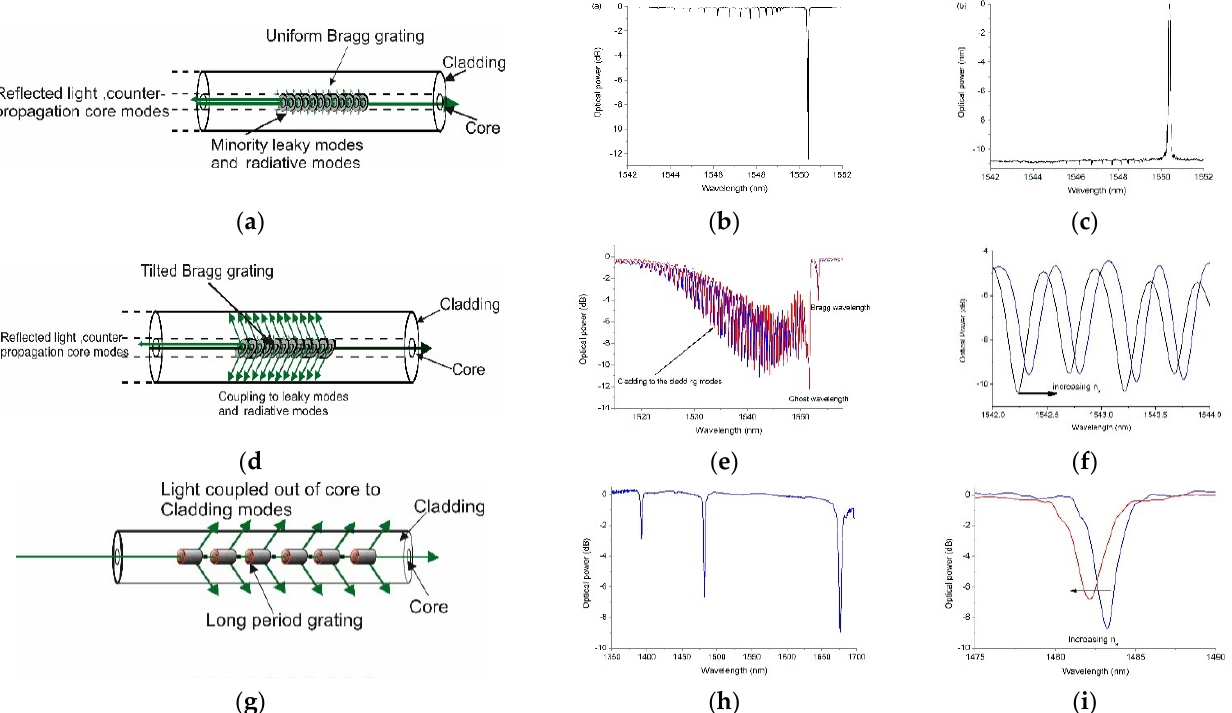
Figure 2. The three types of fibre grating sensors and their spectral response. ( a ) Schematic of fibre Bragg grating. ( b , c ) A typical fibre Bragg grating spectral response in reflection and transmission. ( d ) Schematic of tilted fibre Bragg grating. ( e , f ) A typical tilted fibre Bragg grating spectral response in transmission and the response to change in the surrounding medium index. ( g ) Schematic of long period grating. ( h , i ) Spectral responses in transmission and the response to change in the surrounding mediums index.